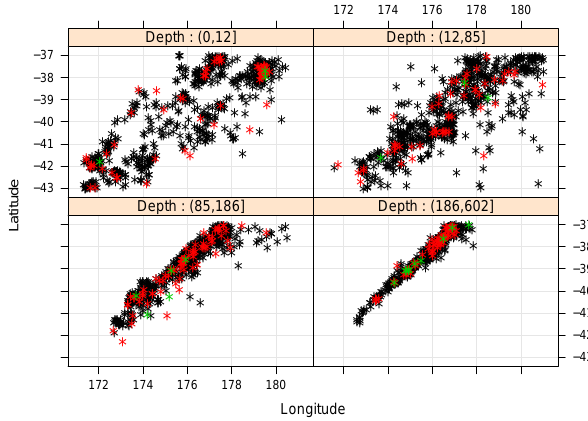
Fig. 1. 3-D space plot, with depth discretized into four groups with equispaced quantiles as breakpoints, so that all groups have roughly the same number of points. Different colors are used for different ranges of magnitude: black for 4 . 5 ≤ M < 5 . 4, red for 5 . 4 ≤ M < 6 . 3 and green for 6 . 3 ≤ M < 7 .